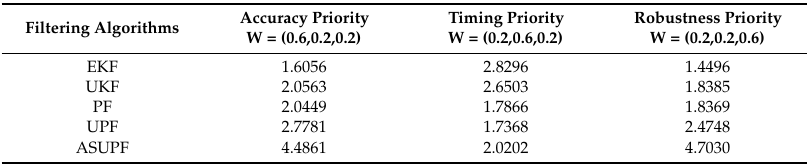
Table 6. Overall performance indexes of the nonlinear filtering algorithms. Filtering